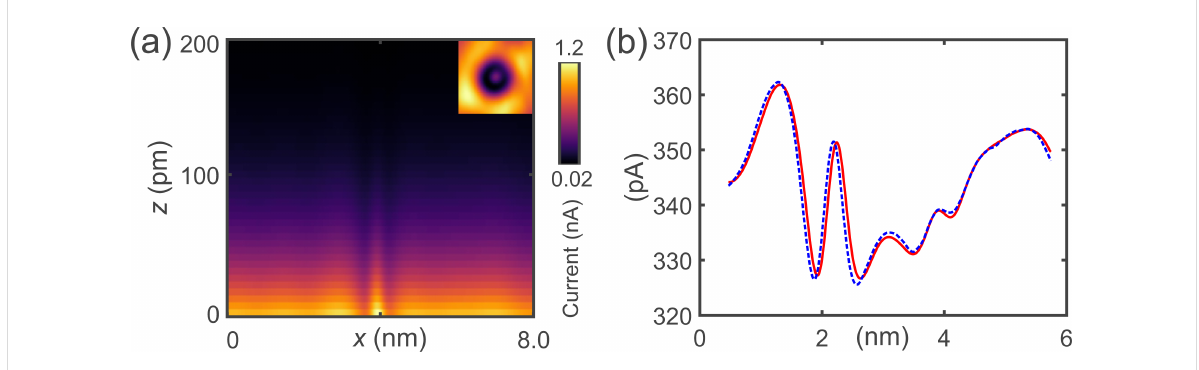
Figure 7: Two-dimensional (2D) current map without oscillation and calculated and recorded curve with oscillation. (a) 2D current map of a carbon monoxide molecule (CO) on Cu(111) taken with a CO molecule adsorbed on the tip (CO tip). The dashed white line indicates the current line at z 0 at which the 2D current map is used to calculate the curve with oscillation. The inset shows a constant current STM image of a CO on Cu(111), which is used for the 2D current map. (b) Line profile of a constant-height scan of a CO molecule on Cu(111) with a CO tip with oscillation shown by the red solid curve. The fit uses the 2D current map yielding an amplitude A = 890 pm ± 2% and sensor tilt of θ = 2.00° ± 2% shown by the blue dashed